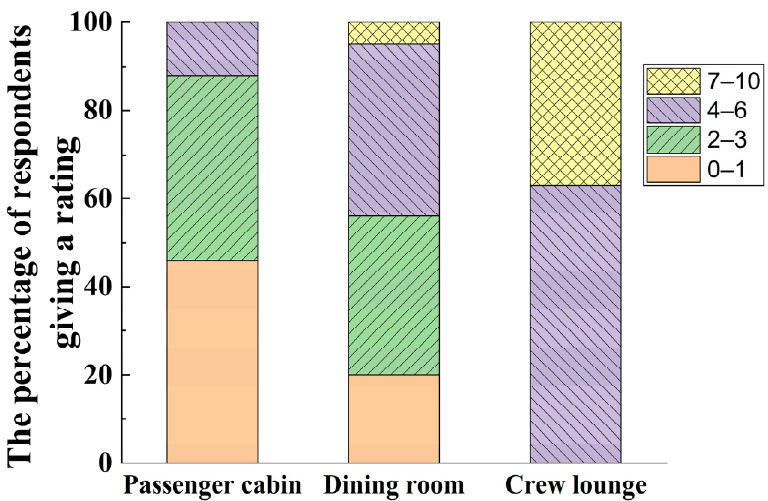
Figure 3. The distribution of respondents’ ratings in three